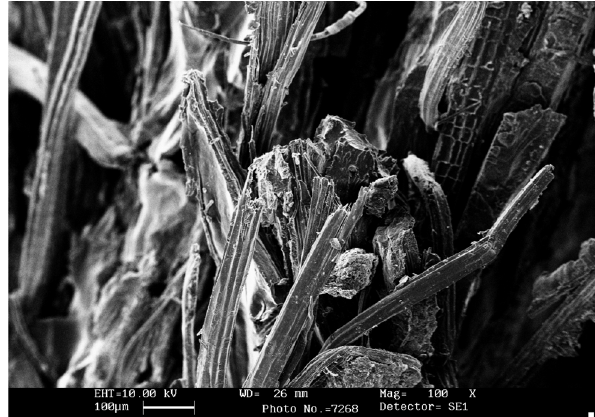
Figure 17: SEM for (15% jute fiber by weight) composite material with coating at 100×.